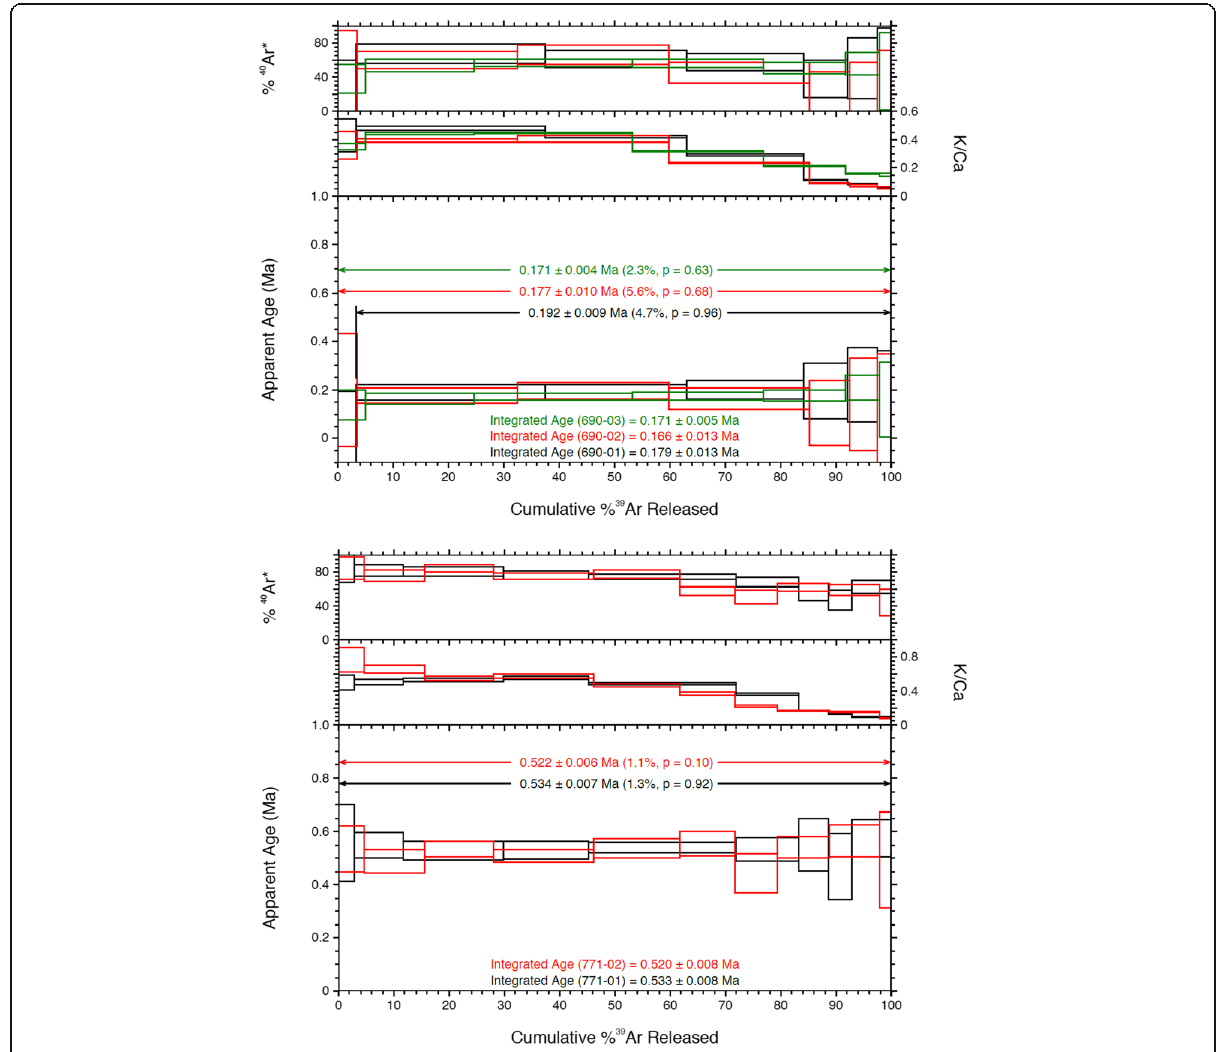
Fig. 8 Age spectra of representative samples of Jeongok